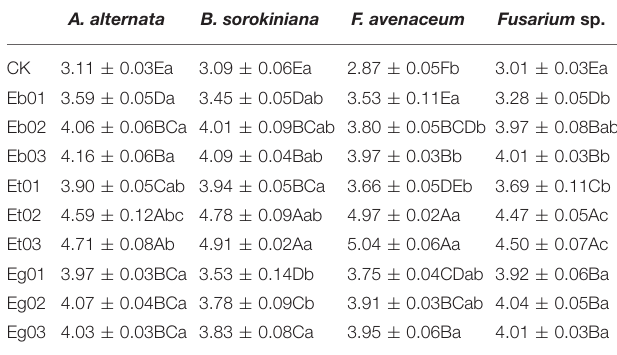
TABLE 3 | Coleoptile length (cm) of Epichloë endophyte-infected Elymus sibiricus under seed-borne fungi stress.